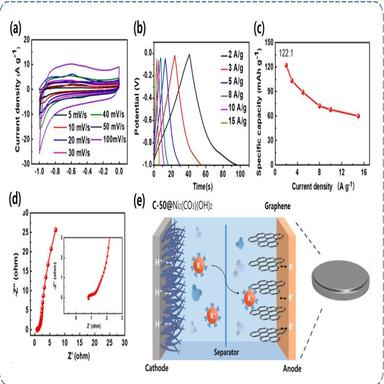
(a) CV curves obtained using graphene as the negative electrode at different scan rates; (b) galvanostatic CD of graphene at different current densities; (c) specific capacities of graphene; (d) EIS Nyquist plot of graphene; (e) schematic representation of the optimized C-50@Ni2(CO3)(OH)2//graphene ASC device.